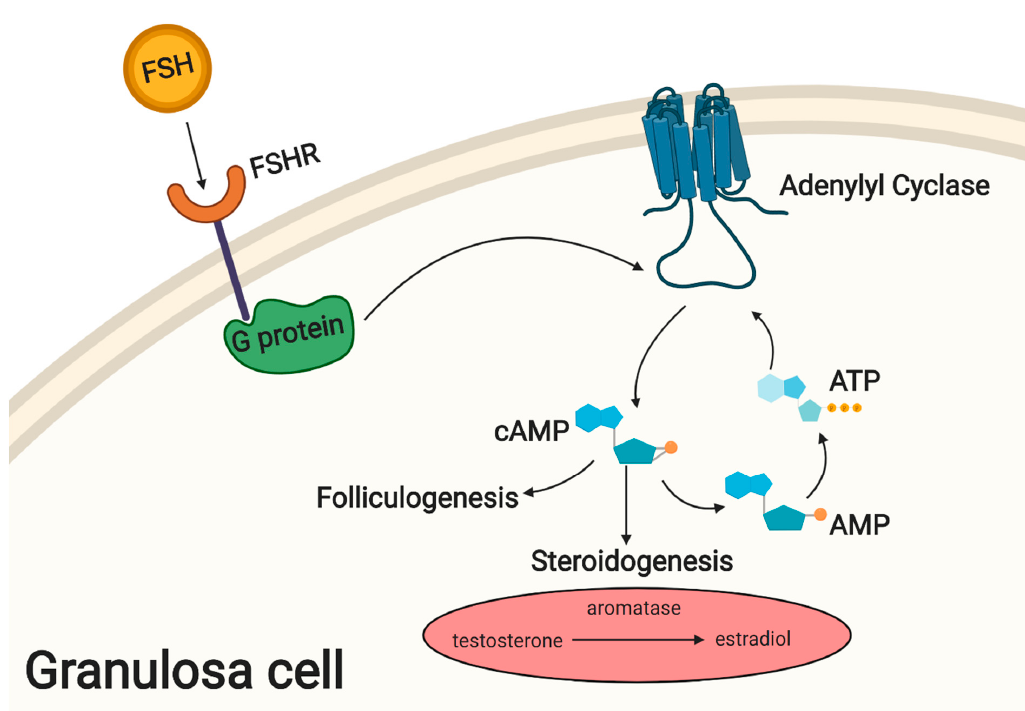
Figure 1. FSH & the cAMP pathway in granulosa cells.